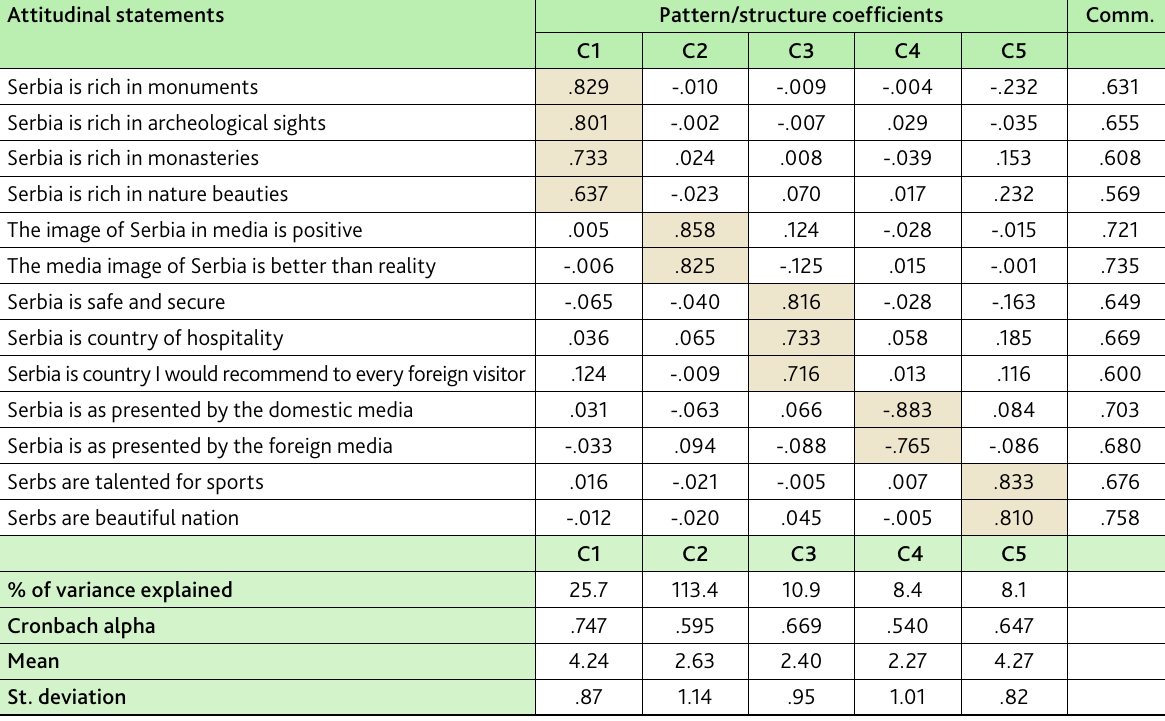
Table 8. Serbia brand identity Serbian perception –rotated component matrix for PCA with Oblimin rotation for 5 factor solution Attitudinal